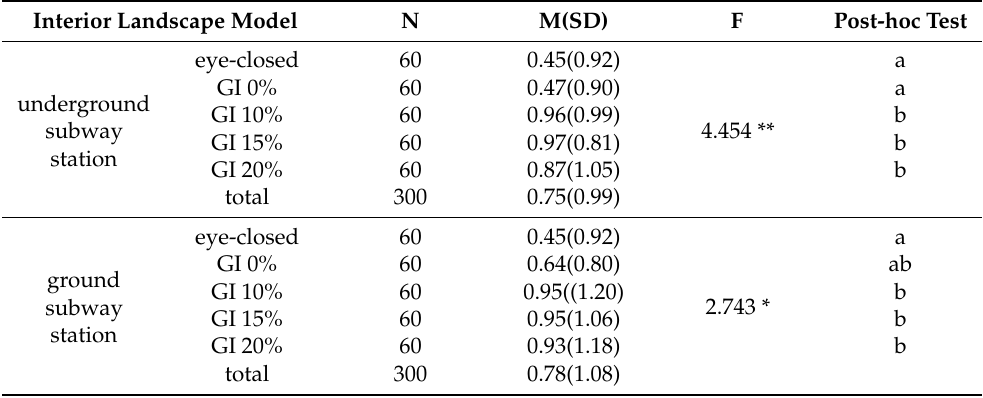
Table 3. Prefrontal Alpha Asymmetry of Subway Interior Landscape Models with